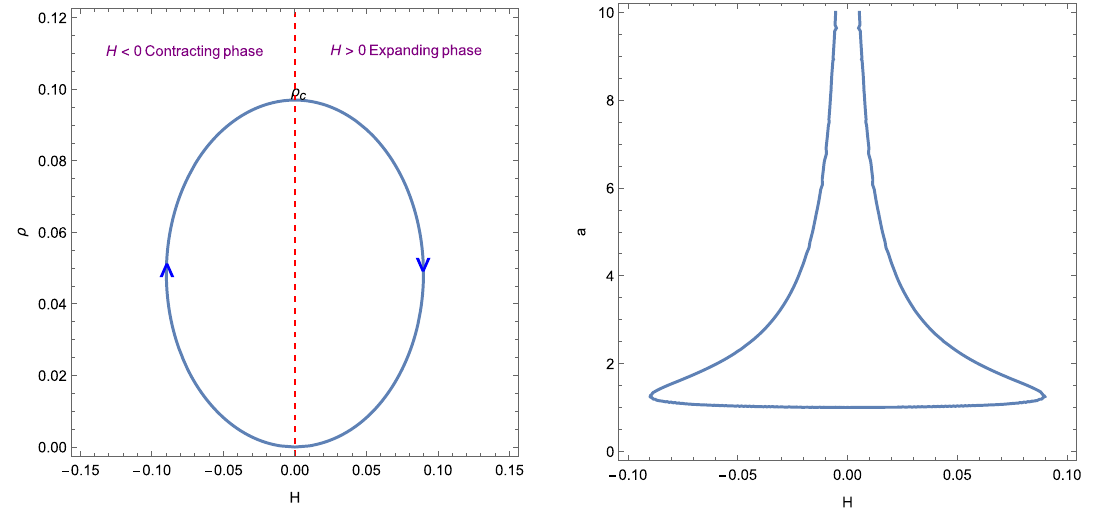
Fig. 2 Evolutionary behaviour of energy density (left panel) and scale factor (right panel) in Hubble parameter